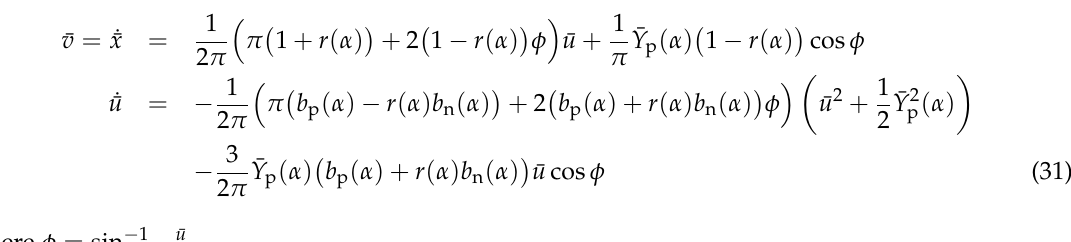
Figure 8. With the rest of the physical parameters being the same as in Section 2.4, using Equations (35) and (31), one determines the optimum angle α m ≈ 8.7 ◦ and the maximum average velocity of the swimmer ¯ v m ≈ 0.67 cm/s, respectively. The simulation results using three fin angles α 1 = 5 ◦ , α 2 = α m , and α 3 = 13 ◦ and zero initial conditions are shown in Figure